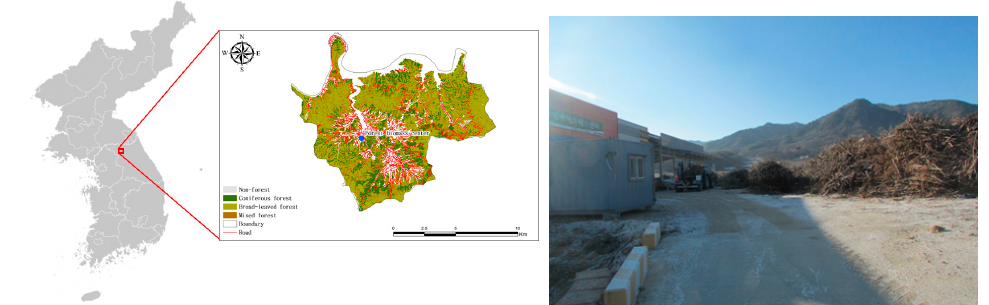
Figure 1. Location of the study site.